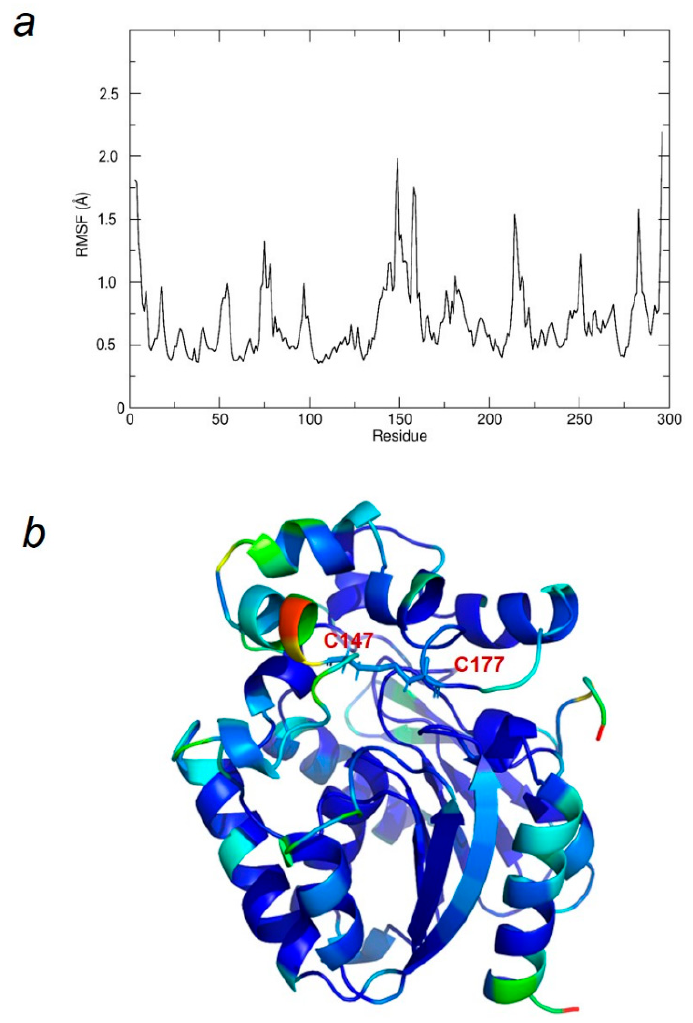
Figure 5. Flexibility of LinB MD D147C+L177C individual residues. ( a ) The RMSF of LinB D147C+L177C mutant during MD simulation at 300 K; ( b ) LinB MD D147C+L177C mutant rep- resented as a 3D cartoon model with each residue coloured by RMSF values in the range from 0.03 nm (= 0.3 Å, blue) to 0.22 nm (= 2.2 Å, red), D147C-L177C disulfide bond shown as sticks.